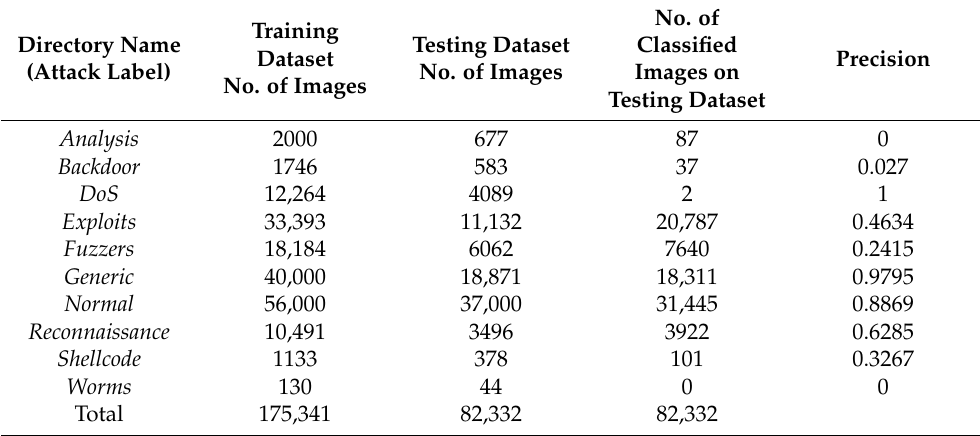
Table 4. Precision of recognized images using ML.NET created model on UNSW-NB15 train- ing